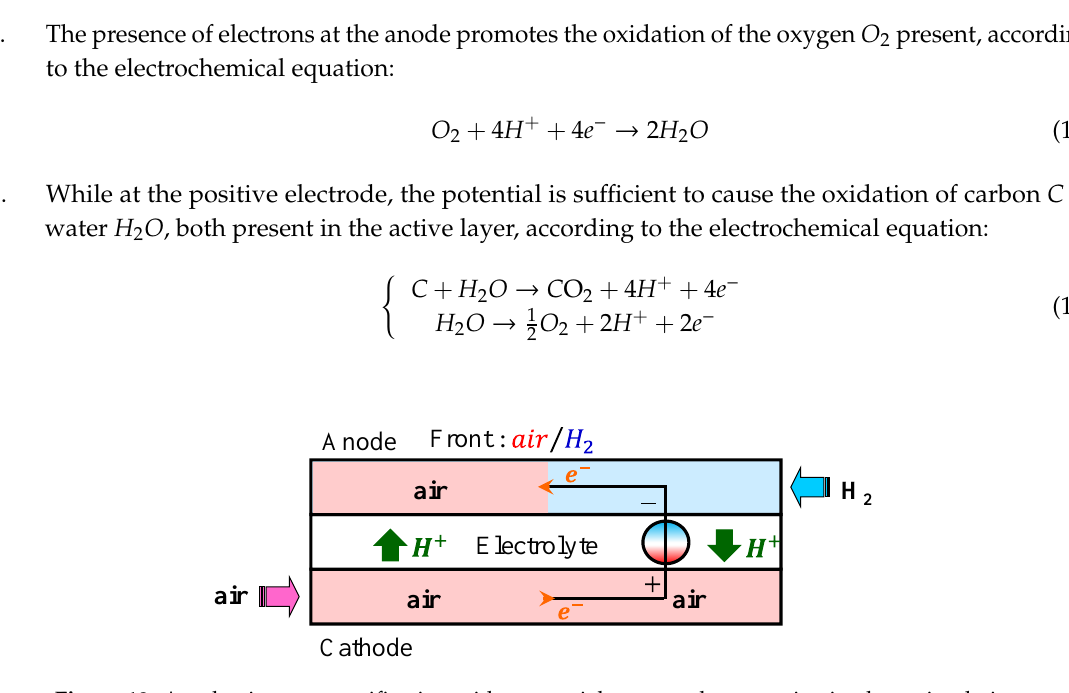
Figure 18. Anode nitrogen stratification without partial pressure homogenization by recirculation.